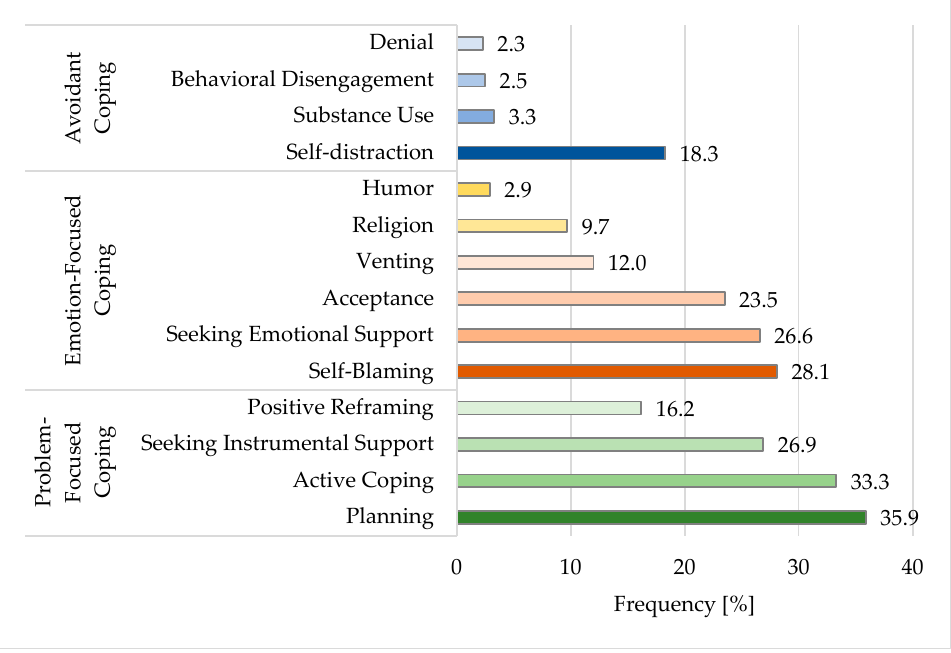
Figure 1. Frequency of choosing Coping Strategies (Brief-COPE) in the tested population.